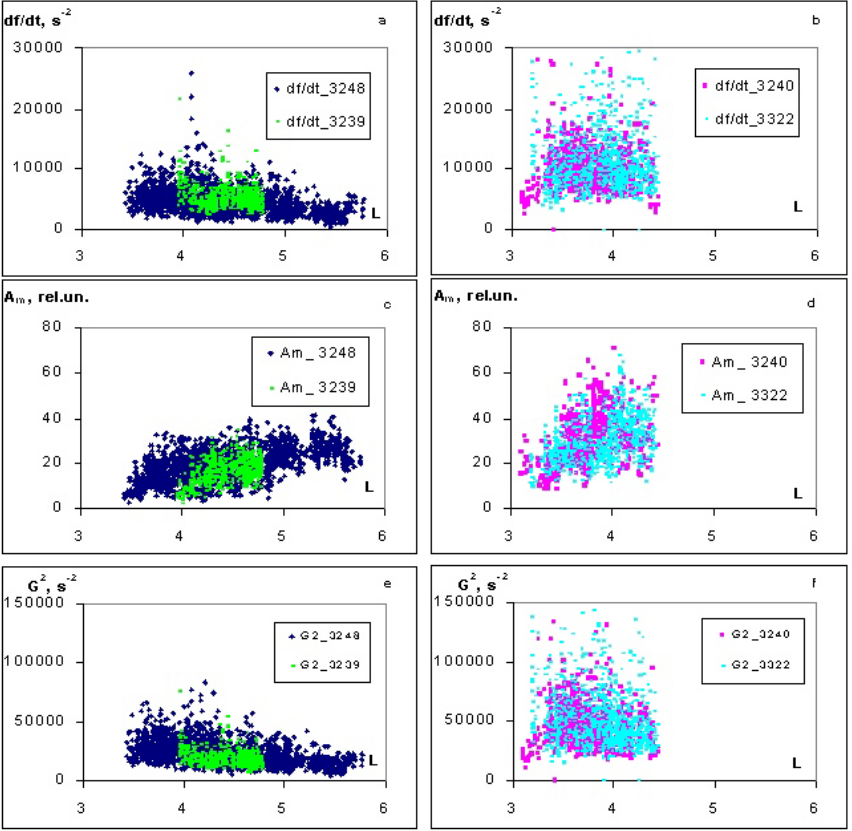
Fig. 4. The frequency sweep rate df/dt (a, b) , chorus amplitudes (c, d) , and G 2 (e, f) as a function of L-shell for 4 orbits of Magion 5 satellite. Note that df/dt is significantly greater on orbits 3240 and 3322 than on orbits 3248 and 3239. Figure shows that the high frequency sweep rate df/dt and G 2 are observed on the orbits having high chorus amplitudes (orbits 3240,